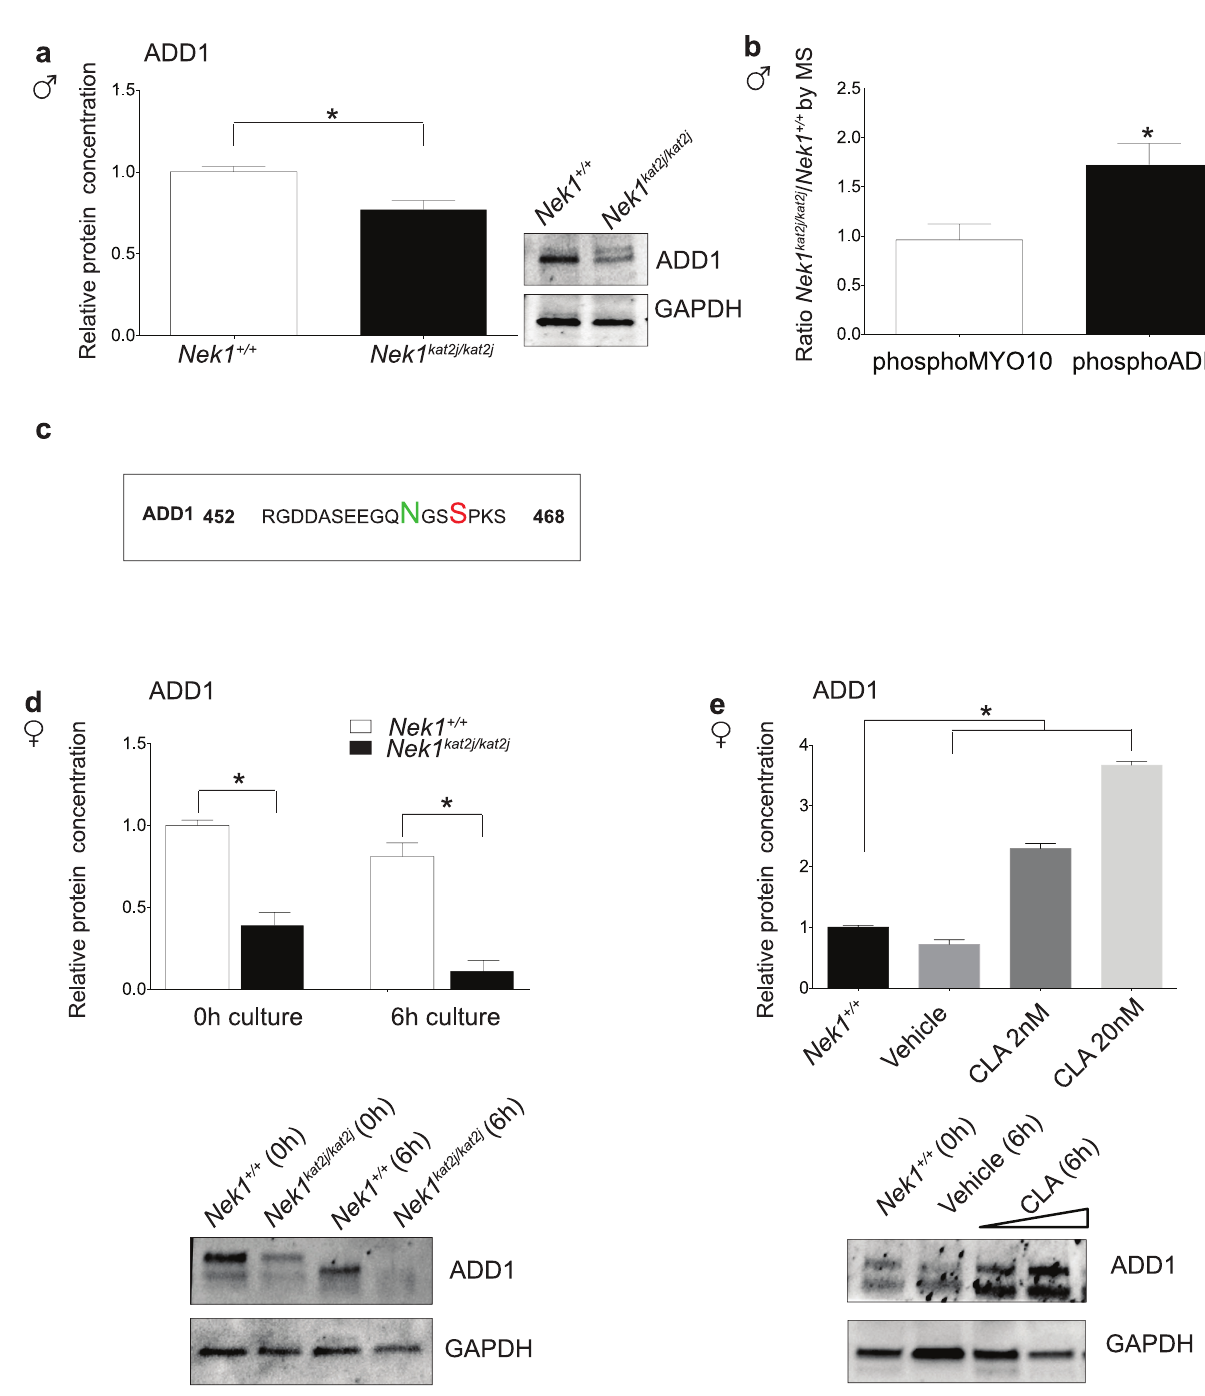
Fig 6. Loss of NEK1 during meiosis is associated with hyper-phosphorylation and reduced ADD1 protein in a PP1 γ -dependent manner. (a) Quantitation of ADD1 protein levels in Nek1 +/+ testis extracts relative to GAPDH control. (b) ADD1 and MYO10 protein levels, expressedas a ratio of Nek1 kat2j/kat2j / Nek1 +/+ , as determined by mass spectrometry. (c) ADD1 phosphopeptide and deaminatedpeptide sequencedetermined by mass spectrometry to be higherin Nek1 kat2j/kat2j testis extracts. (d) Quantitationby western blotting of ADD1 protein levels in oocytes at 0h and after 6h of culture. (e) Quantification of ADD1 protein levels in wildtype oocytes cultured for 6h in vehicle(ethanol) and the PP1 inhibitorCalyculin A (CLA) (at doses of 2 and 20 nM). All values are means ± Standarddeviation. * Indicate statistically significant differences (Unpairedt test p < 0.05 and one-wayANOVA followedby Dunnett’s multiple comparisons test, p < 0.05, for cultures with inhibitor)